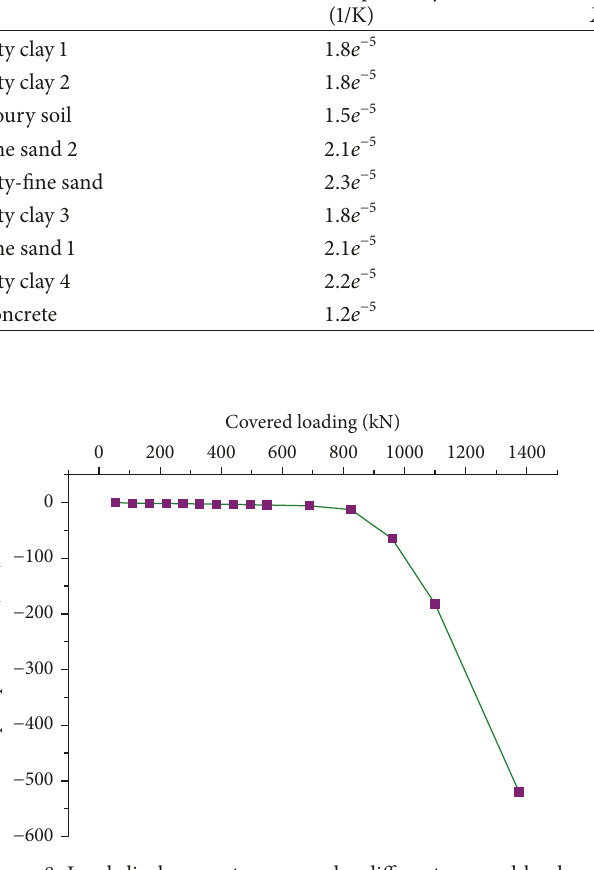
Figure 8: Load-displacement curve under different covered load- ing.